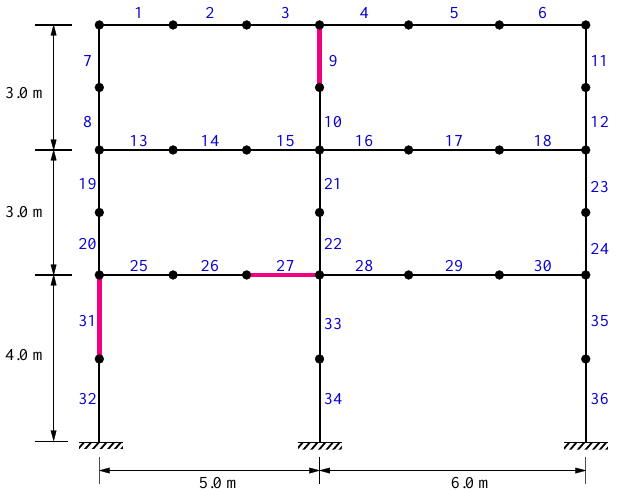
Figure 11. A two-bay three-story frame. Figure 12 demonstrates the average identification results achieved by VPSS, LAPO, GWO, DE, and PSO in both the noise-free and noisy conditions. Additionally, Table 5 summarizes details about the average values, standard deviations, and the maximum